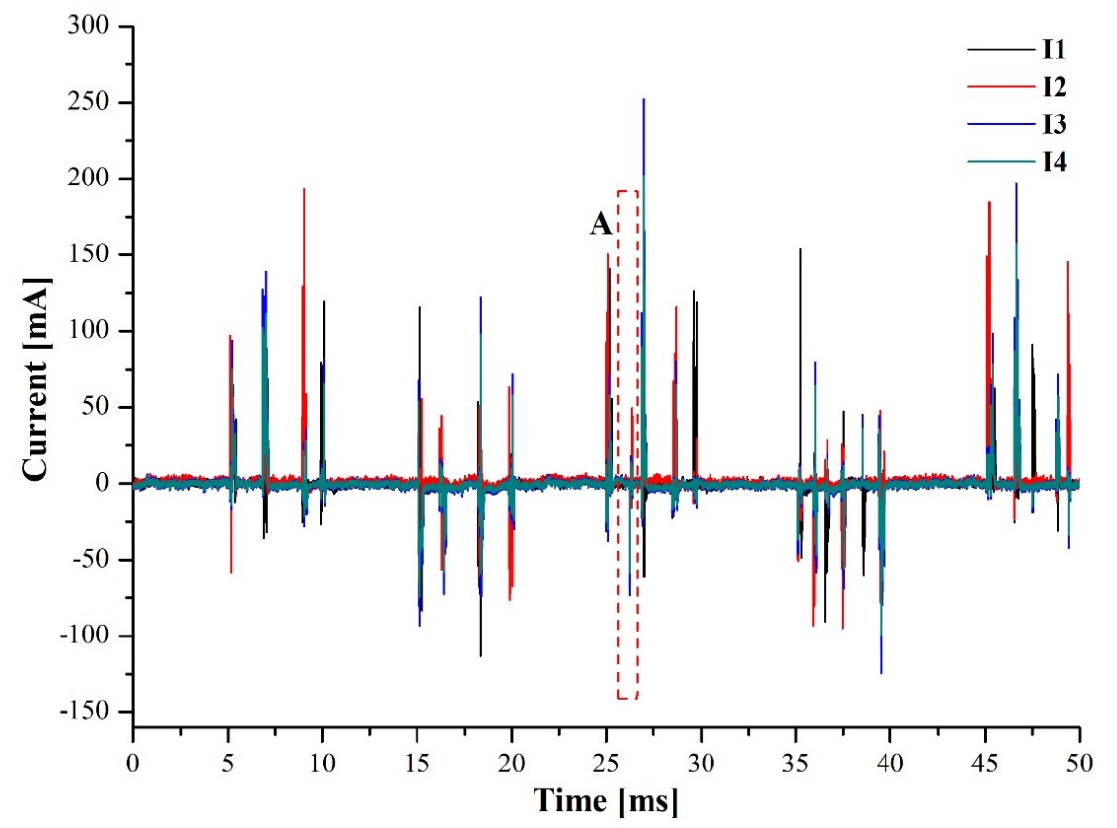
Figure 9. The current waveforms of the four NTP multi-reactors (R1–R4)—CCL type working in parallel.